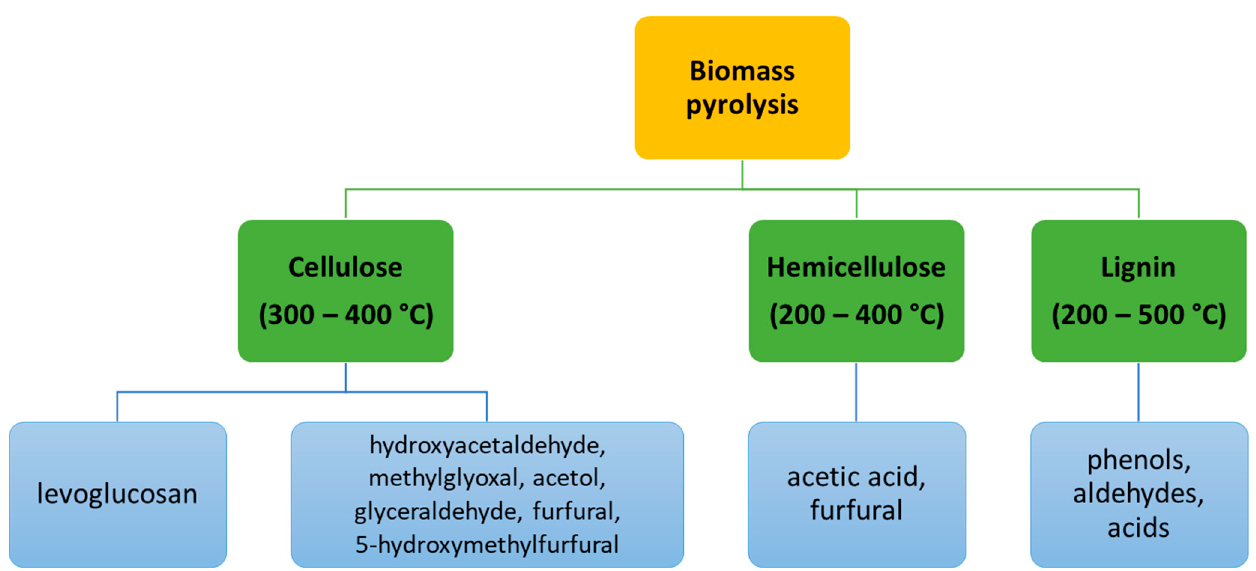
Figure 2. Major components of pyrolytic bio-oil [29].